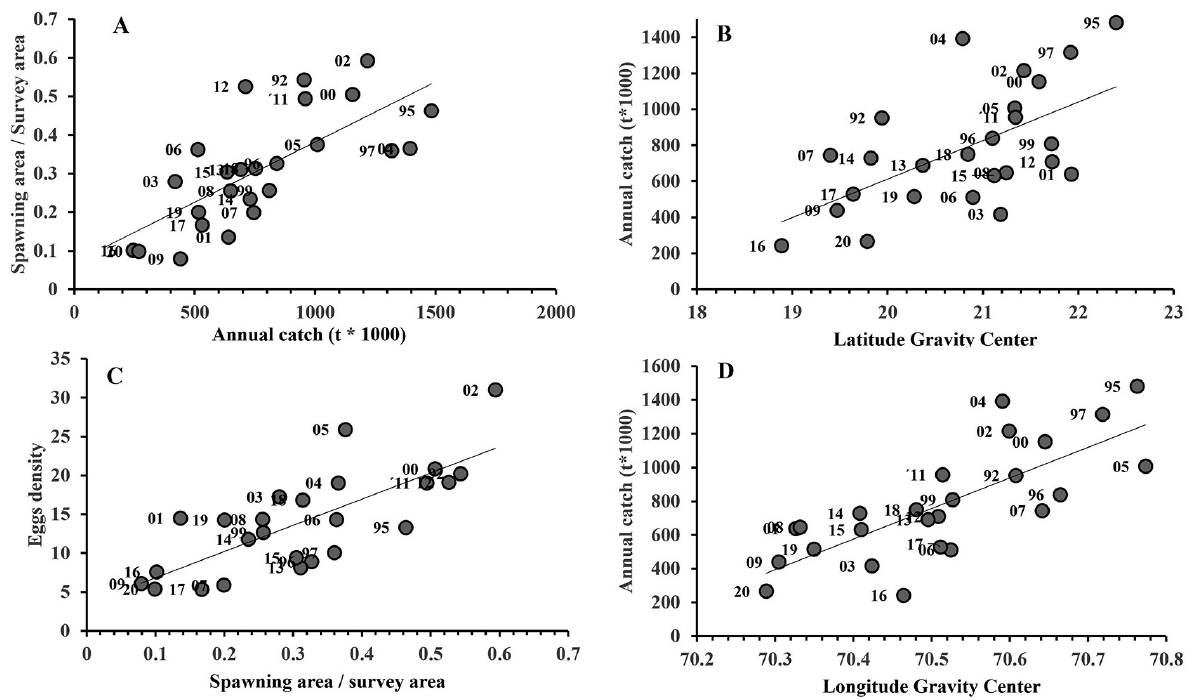
Fig. 3. – Relationship between annual catch and spawning area (as a proportion of the survey area) (A). Egg distribution latitude (°S), centre of gravity and annual catch (B). Spawning area and egg density (N°/0.05 m 2 ) (C). Egg distribution longitude (°W), centre of gravity and annual catch (D). Numbers indicate year.